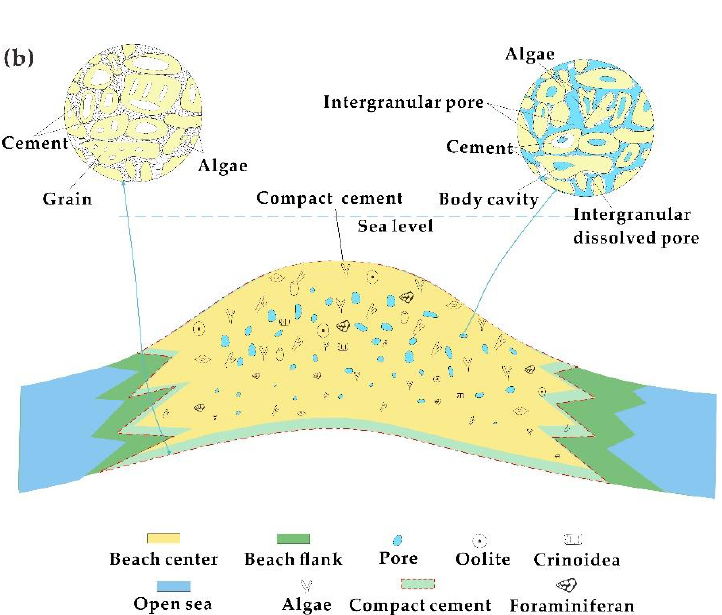
Figure 10. Environmental model diagram of exposed and non-exposed beaches. The exposed and unexposed beaches ( a , b ) represent the sedimentary environment of KT-I and KT-II layers respectively, which explains the origin of different petrophysical facies.